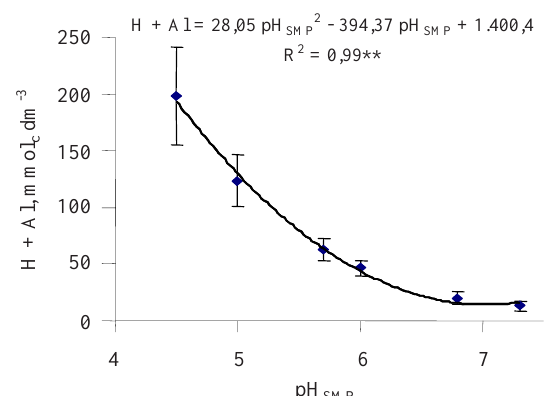
Figura 2. Relação entre os teores médios de H + Al, (Quadro 2) e o pH SMP, para solos de